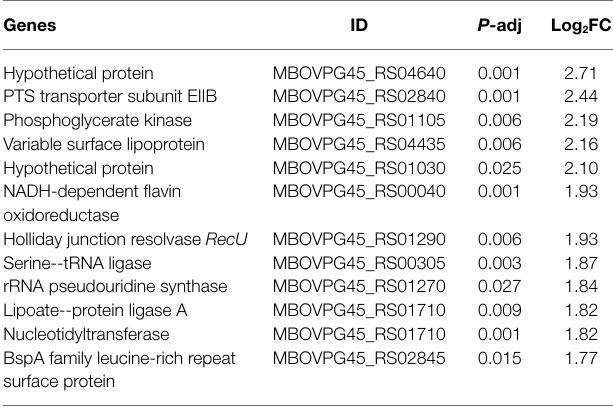
TABLE 3 | The 12 most downregulated genes after CAR treatment based on Log